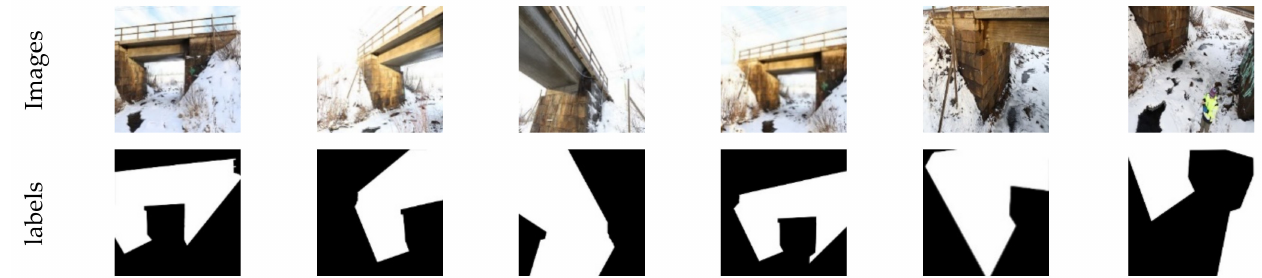
Figure 6. Examples of the prepared dataset for bridge component detection and their corresponding labels.